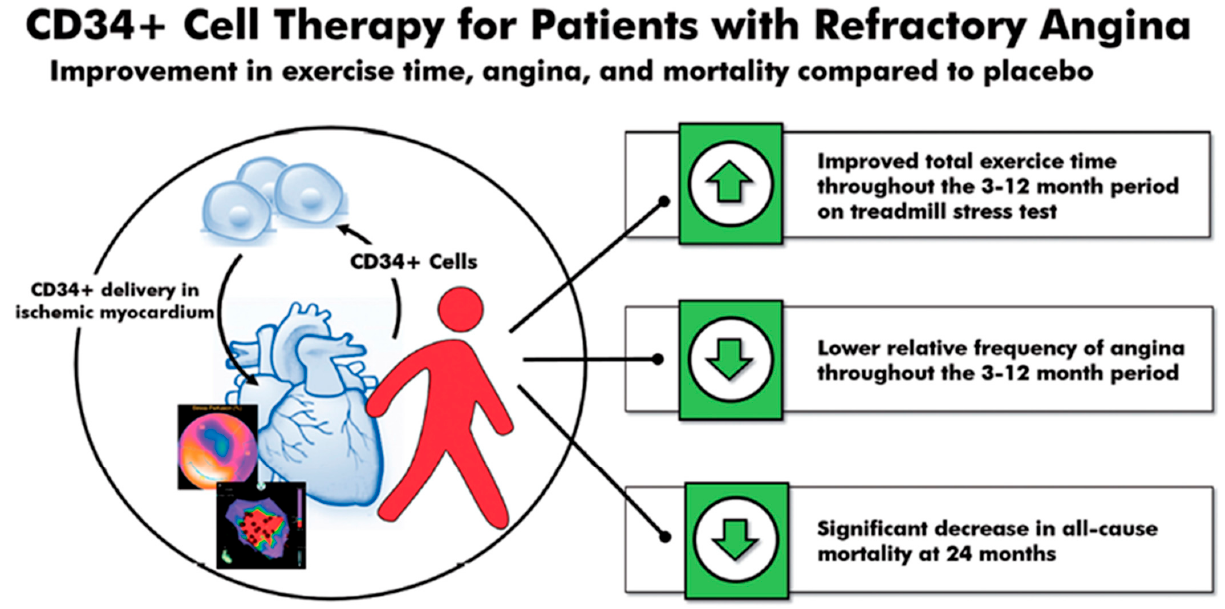
Figure 1. CD34 + cell therapy for patients with obstructive coronary artery disease and refractory angina. Results from the 2018 meta-analysis of three consecutive randomized, double-blinded, placebo-controlled trials in patients with obstructive coronary artery disease and Canadian Cardiovascular Society class 3–4 refractory angina showed that a single intracoronary infusion of autologous CD34 + cells significantly improved total exercise time, decreased angina frequency, and decreased all-cause